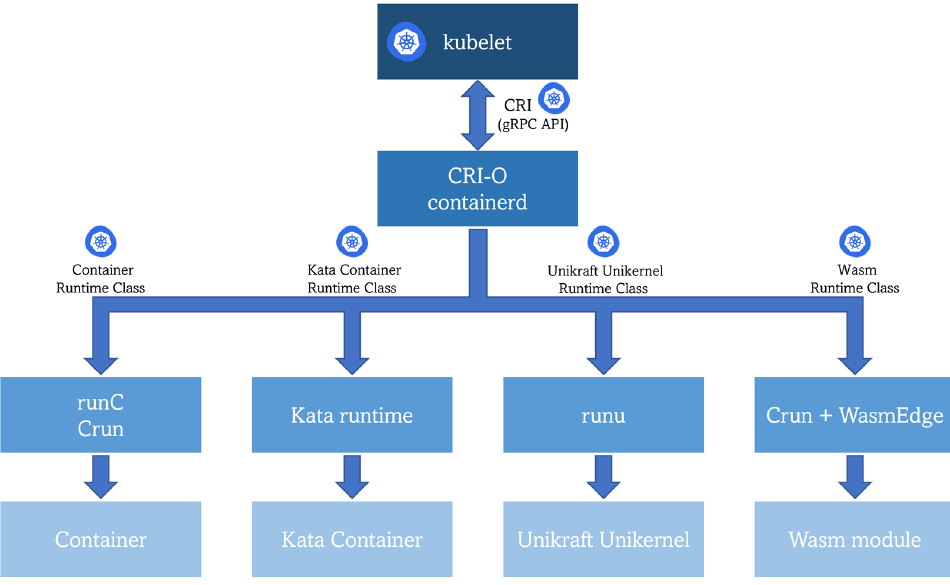
Figure 8. Running different types of workloads in K8s.